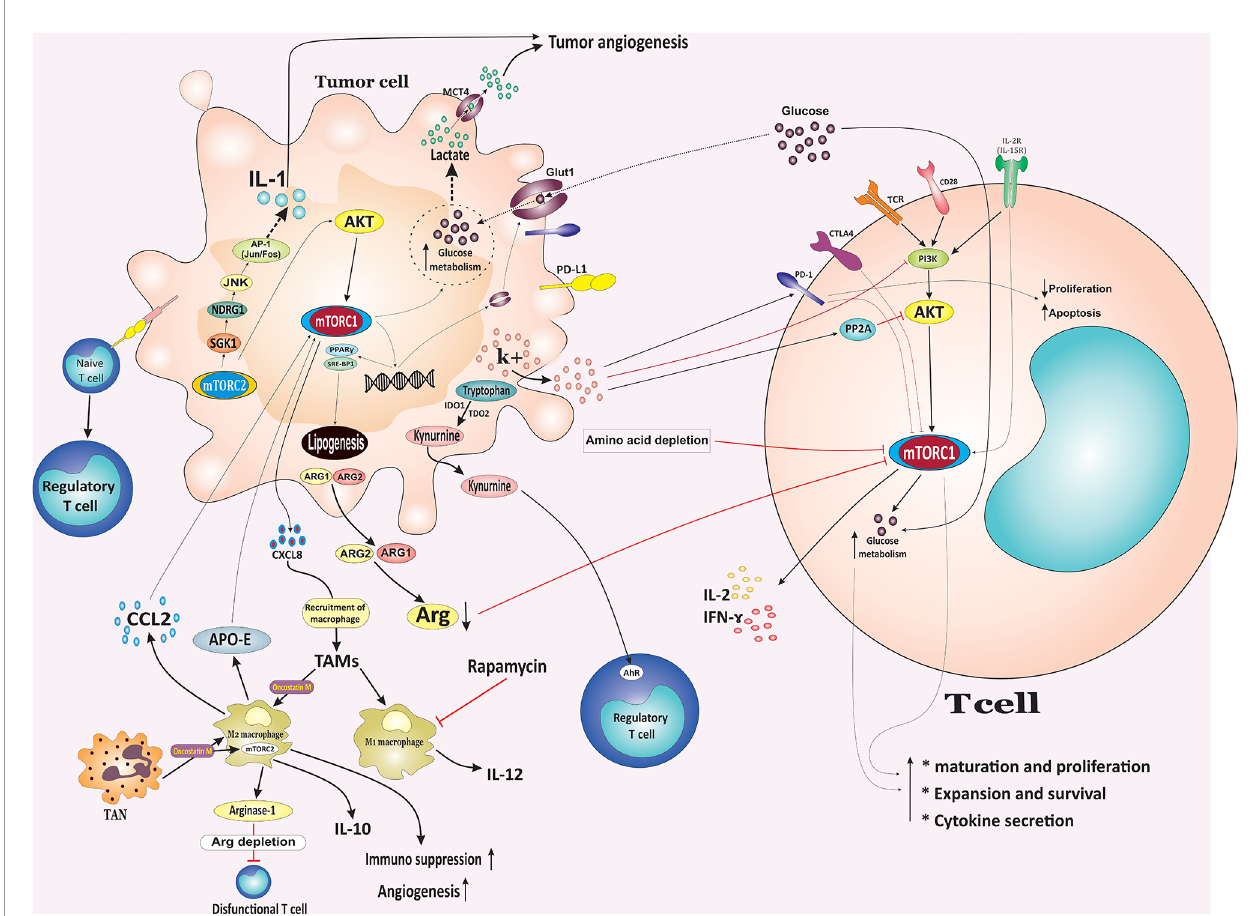
FIGURE 2 | Metabolic competition between tumor cells and T cells in the tumor microenvironment. The nutrient interplay between malignant and nonmalignant cells, especially immune cells, can potentially in fl uence cancer cells growth, survival, and function. Tumors might inhibit immunity through nutrient consumption and simultaneously produce metabolites to inhibit T cell function, resulting in tumor escape from the immune system. In TME, tumor cells outcompete T cells for glucose, leading to sustained mTOR signaling and glycolysis in the tumor cells. Additionally, increased glycolysis by tumor cells leads to the release of lactate via MCT4, which enhances immunosuppression and angiogenesis. In contrast to PD-1 and CTLA-4, which inhibit the mTOR-mediated upregulation of glycolysis, the co-stimulation of the CD28 signaling pathway and signaling mediated via cytokines such as IL-2 and IL-15 activates PI3K/Akt/mTOR pathway to promote the switch of the T cell metabolism to glycolysis. Tumor cells also affect T cells via releasing high-[K+]e, which induced inhibition of TCR-mediated Akt and mTOR phosphorylation and induced the upregulation of PD-1. Cancer cells also evade immune responses by releasing cytosolic ARG1 or mitochondrial ARG2 results in diminished levels of arginine and reduced mTOR activity and inhibition of T cells in the TME. Additionally, upregulation of IDO1 and TDO2 by cancer cells leads to the tryptophan degradation into kynurenine which supports the Treg phenotype in an AhR repentant manner. Overexpression of mTORC2 target SGK1 mediates tumor growth and invasion in different cancer types. Overexpression of the SGK1 target, NDRG1, is suggested to stimulate IL-1 expression and promote tumor angiogenesis through JNK/AP-1 activation. Both mTORC1 and mTORC2 signaling induce lipogenesis and fatty acid uptake through promoting SREBP1 and PPAR g . CCL2 secreted by TAMs render cancer cells resistance through activating the PI3K/Akt/mTOR pathway. TME, tumor microenvironment; mTOR, mammalian target of rapamycin; MCT4, monocarboxylate transporter 4; ARG1, arginase 1; IDO1, indoleamine-2,3-dioxygenase 1; TDO2, tryptophan-2,3-dioxygenase 2; AhR, aryl hydrocarbon receptor; Treg, regulatory T cell; SREBP1, sterol regulatory element-binding protein 1; PPAR g , peroxisome proliferator-activated receptor- g ; CCL2, CC ‐ chemokine ligand 2; TAMs, tumor associated macrophages; PD-1, Programmed cell death protein 1; CTLA4, Cytotoxic T-Lymphocyte Associated Protein 4; NDRG1, N-myc downstream-regulated gene 1 protein; MCT4, monocarboxylate transporter